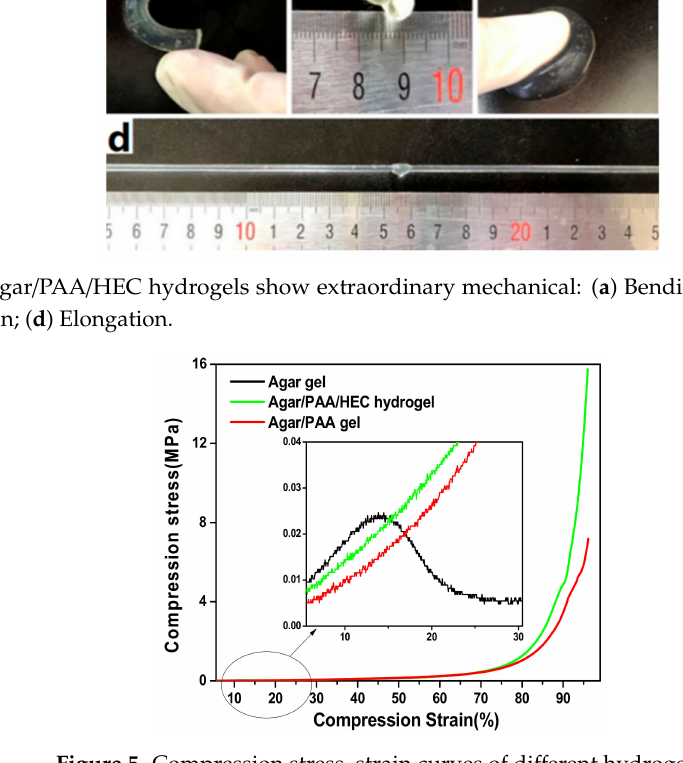
Figure 5. Compression stress–strain curves of di ff erent